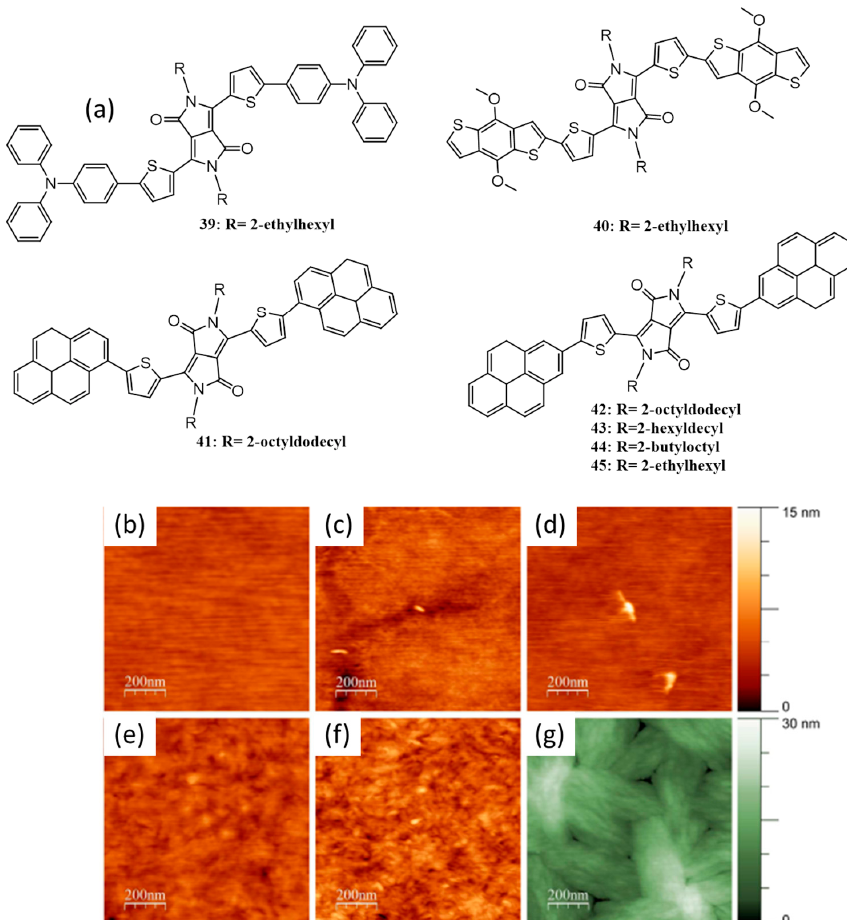
Figure 16. ( a ) Chemical structures of 39 – 45 synthesized by Fréchet et al. [65]. Tapping-mode AFM images of the blends of ( b ) 39 ; ( c ) 40 ; ( d ) 41 ; ( e ) 42 ; ( f ) 43 ; ( g ) 44 with PC 71 BM. Adapted with permission from Ref. [65] Copyright 2011 WILEY-VCH Verlag GmbH & Co., KGaA, Weinheim.